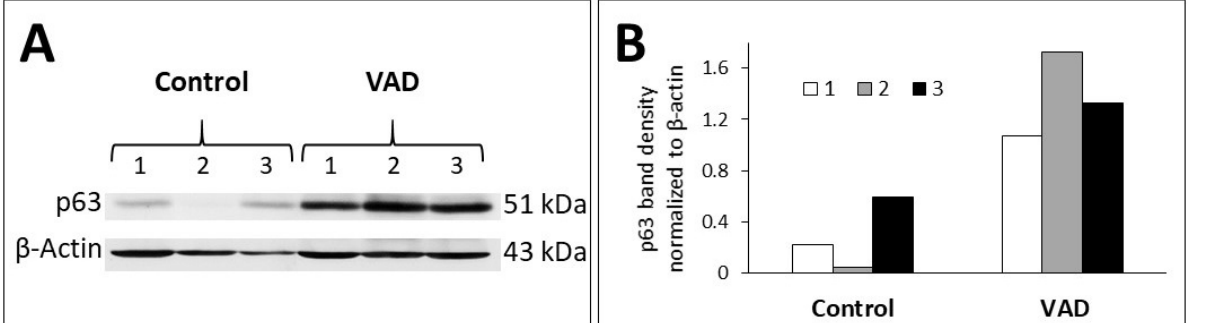
Figure 4. (A) Western blot analysis showing p63 protein bands in gastric tissues obtained from three pairs of male 8-month-VAD mice and their control littermates. Beta actin was used as an internal standard. ( B ) Quantification using ImageJ densitometry and β -actin as internal control reveals p63 upregulation in three VAD stomachs.